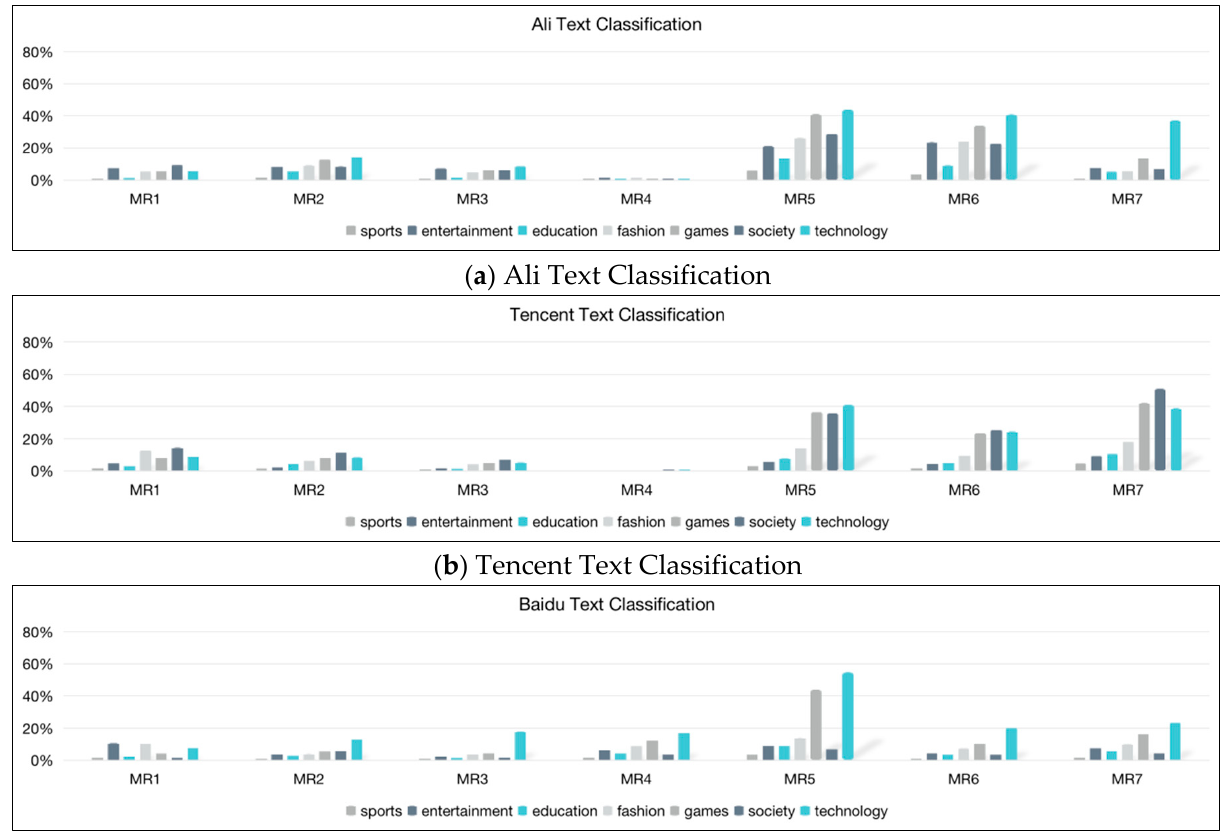
Figure 8. VR of 3 NLP systems on text classification under different news topics.